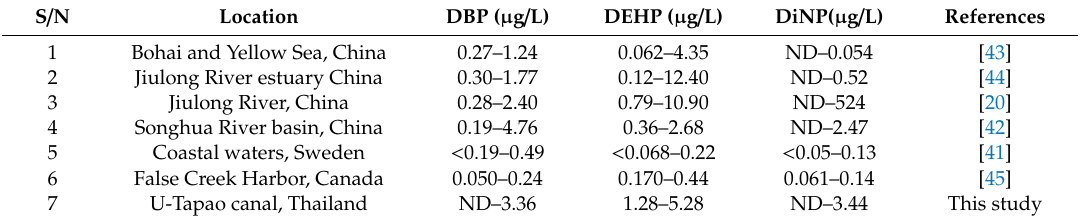
Table 2. Comparison of the concentrations of di-n-butyl phthalate (DBP), di-2-ethyl hexyl phthalate